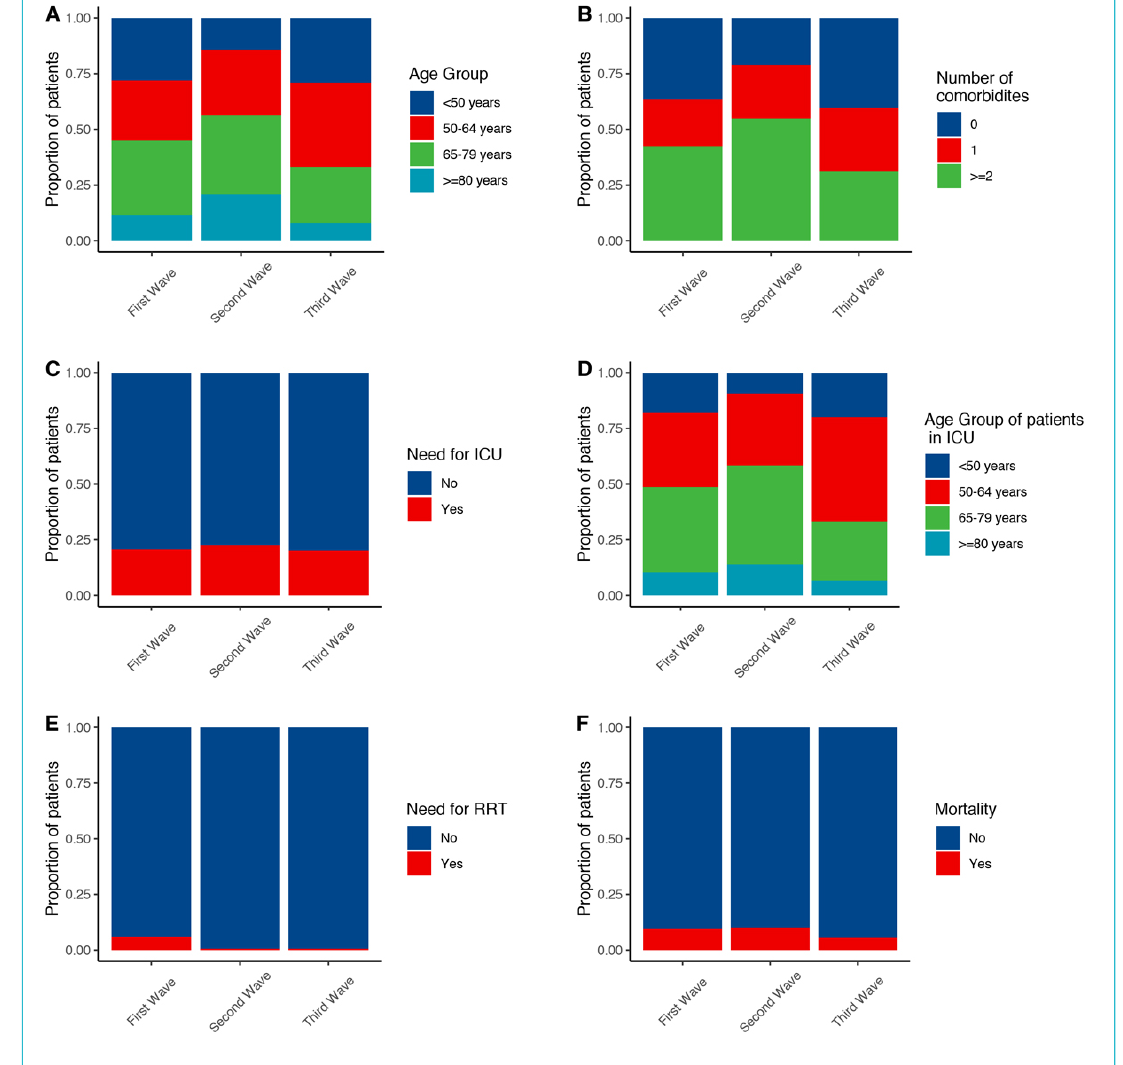
Figure 2: Proportion of patients during the three waves stratified by age (A), number of comorbidities (B), need for ICU (C), age at ICU (D) need for renal replacement therapy during hospital stay (E) and mortality (F). ICU = intensive care unit; RRT = renal replacement